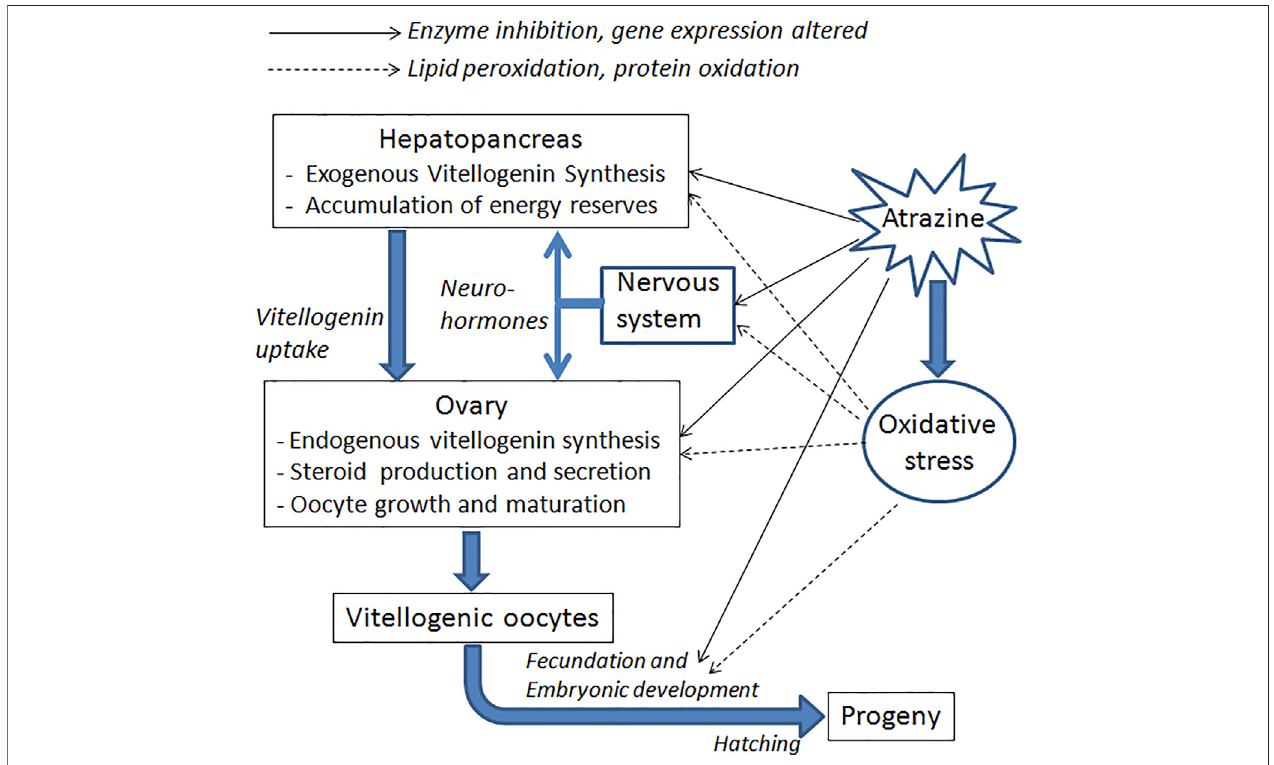
FIGURE 2 | Schematic summary of the main targets and processes likely to be affected by atrazine, concerning crustacean reproduction. Both direct and indirect effects (by inducing oxidative stress) are indicated.